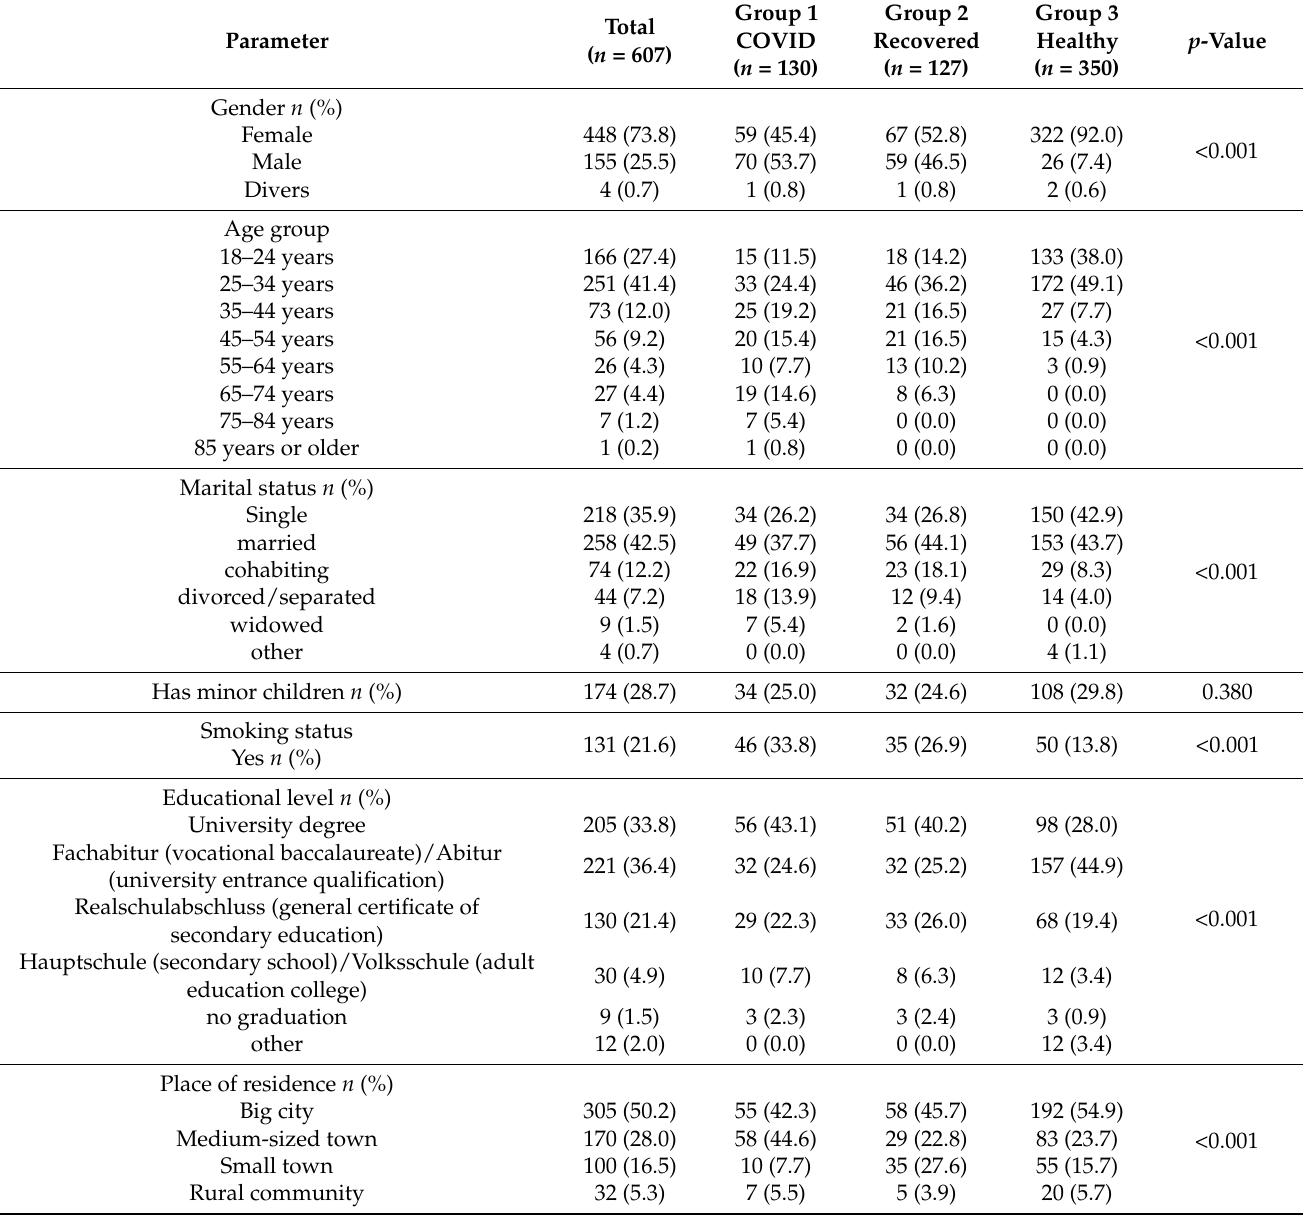
Table 1. Demographic parameters of the study